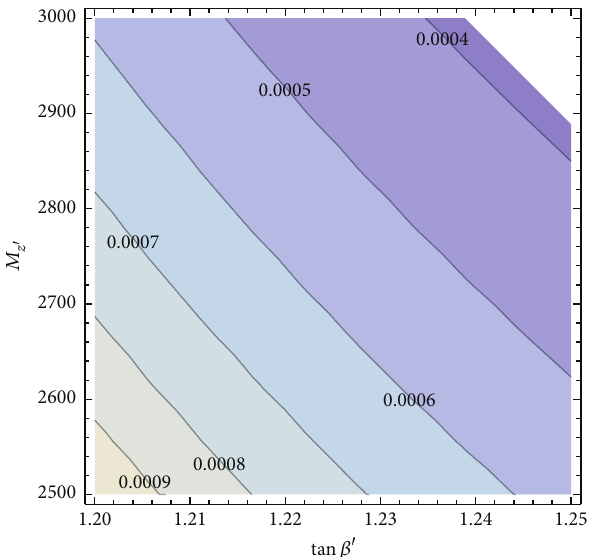
Figure14:Exampleforcontourplotswith SSP and Mathematica : the doublet fraction of the second lightest scalar. We used here EP1 and varied tan 𝛽 󸀠 and 𝑀 𝑍 󸀠